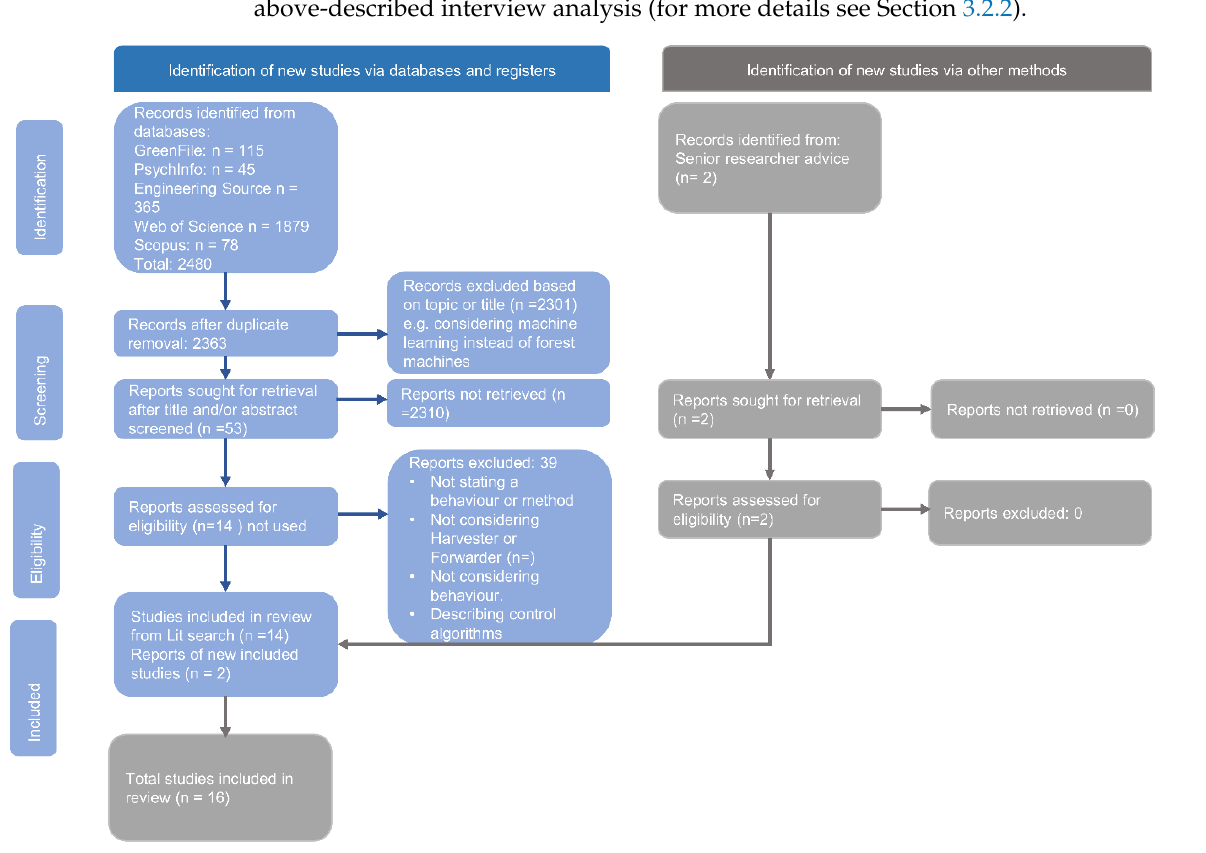
Figure 1. The PRISMA flow diagram shows the process of searching for and identifying relevant literature for this review